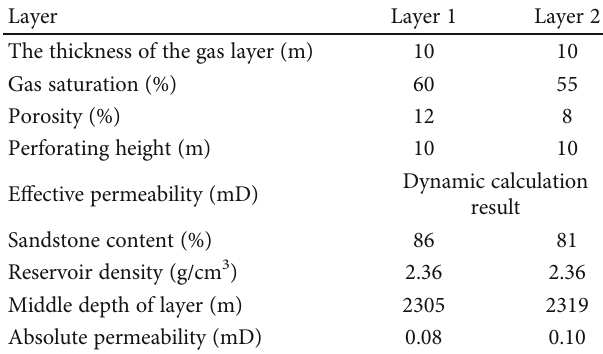
Table 2: The initial parameters of the two reservoirs.